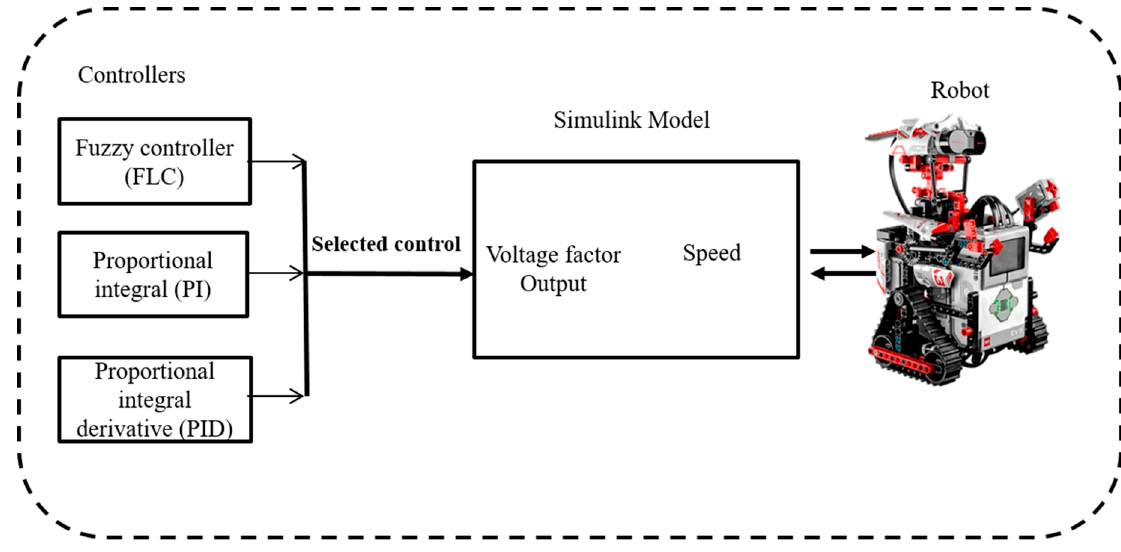
Figure 4. General diagram of the proposed approach.